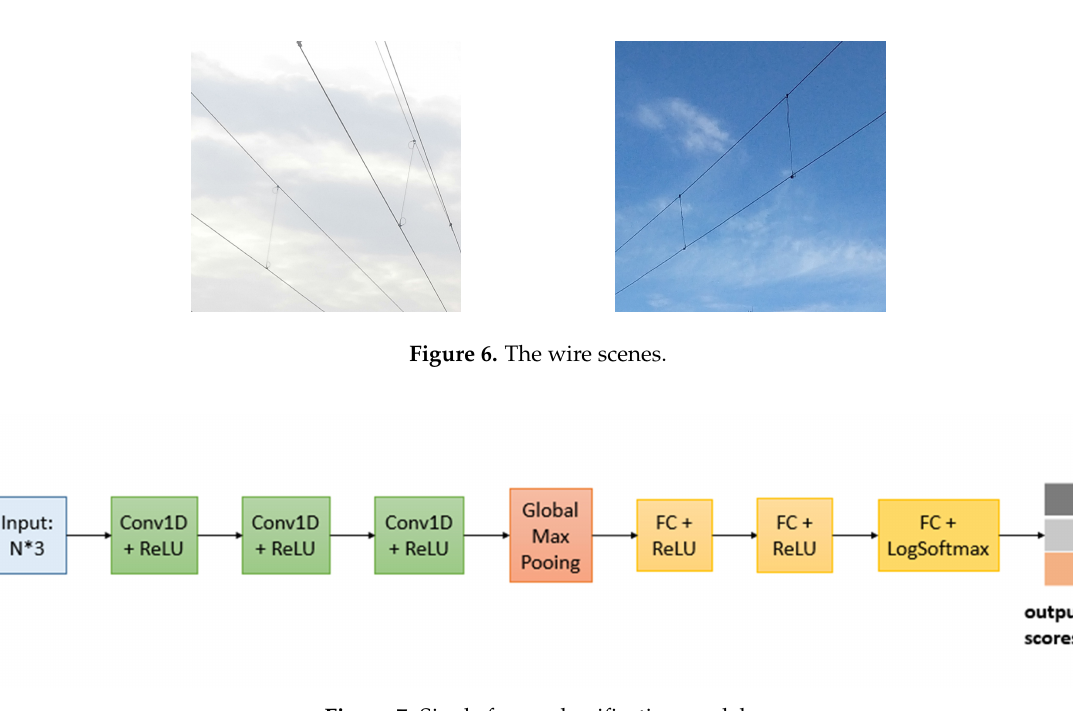
Figure 7. Single frame classification